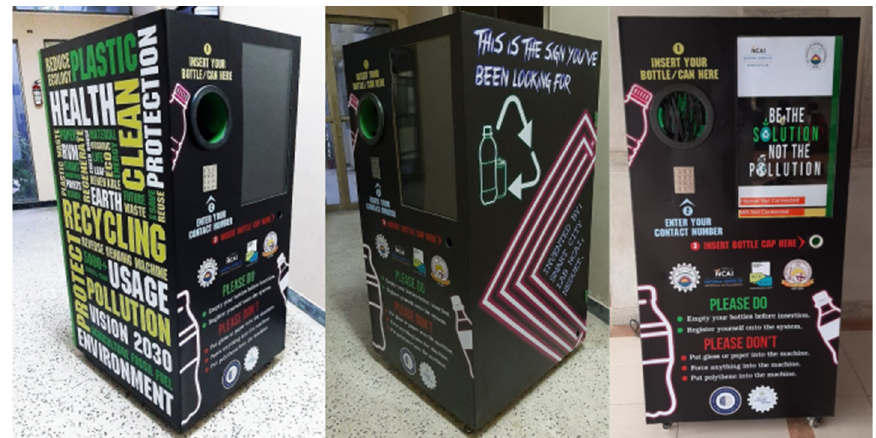
Figure 1. Proposed Reverse Vending Machine.